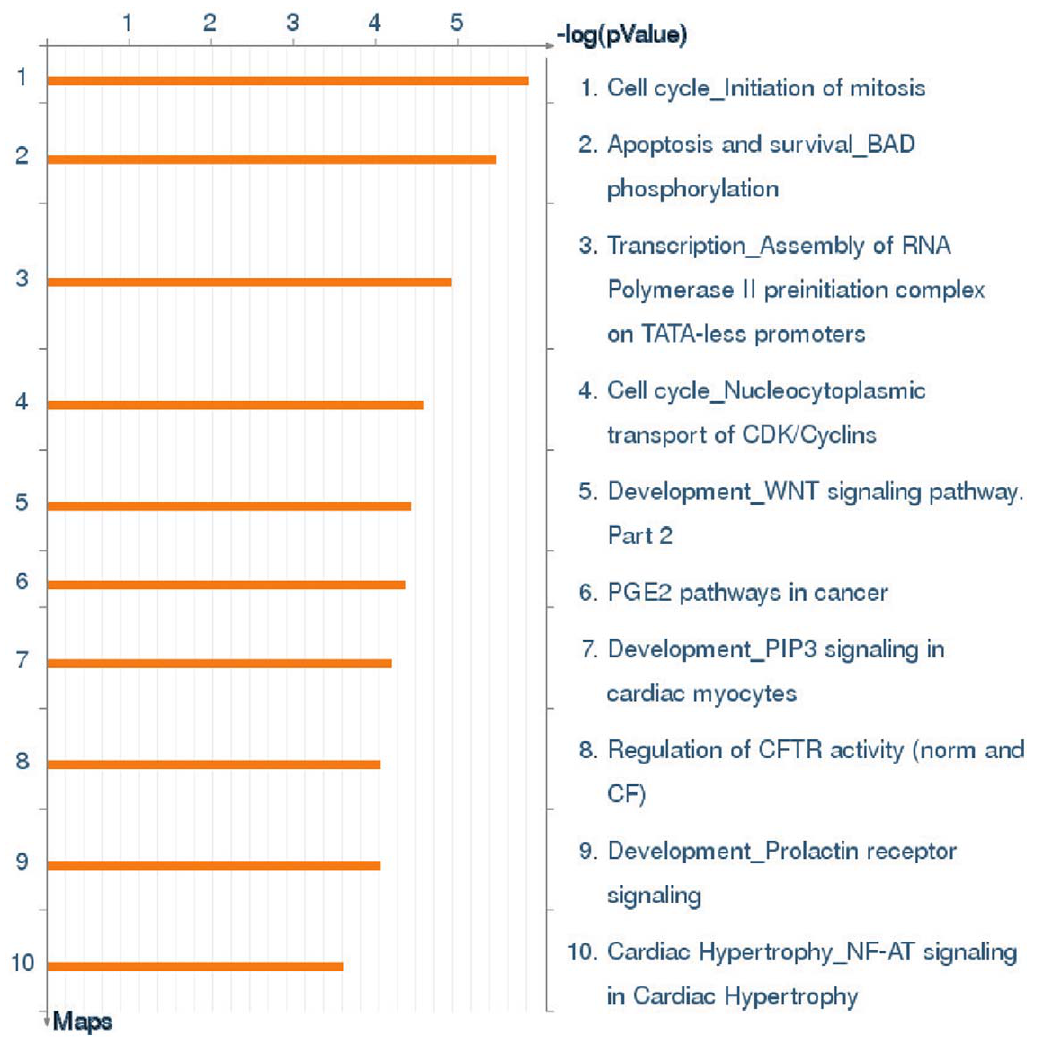
Figure 1. Significant GeneGo pathways affected by prenatal iron restriction in RHL rats. Processes are ranked based upon p-value (P , 0.0003), bars represent inverse log of the p-value.